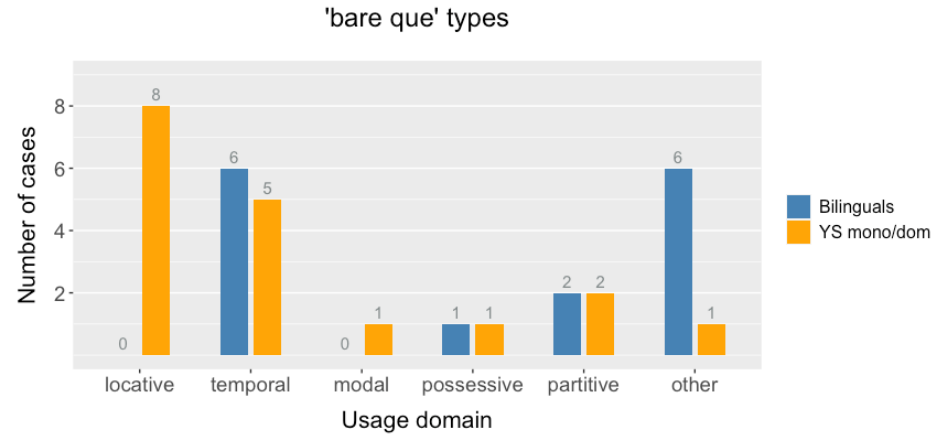
Figure 6. Results for bare que in the relative clause data, according to the usage domains.